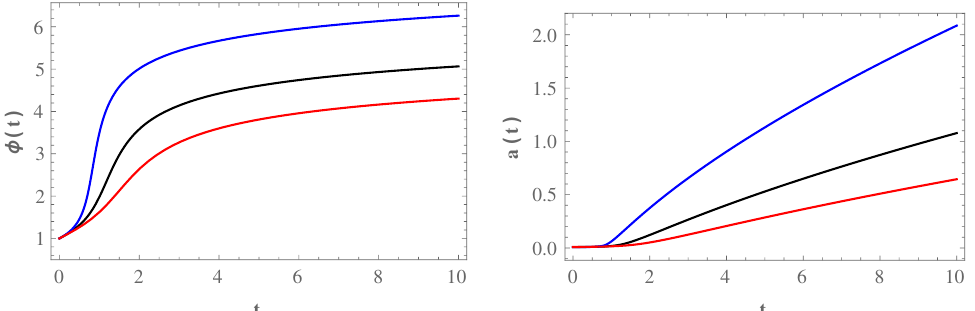
Figure 3. The behavior of the scalar field φ ( t ) and the scale factor a ( t ) against cosmic time for our herein NC model with different values of W . The blue, black, and red curves are associated with W = 2, W = 3, and W = 4, respectively. Except W (which varies here), the values for the initial conditions, other parameters and units are equal to the corresponding ones chosen for the Figure